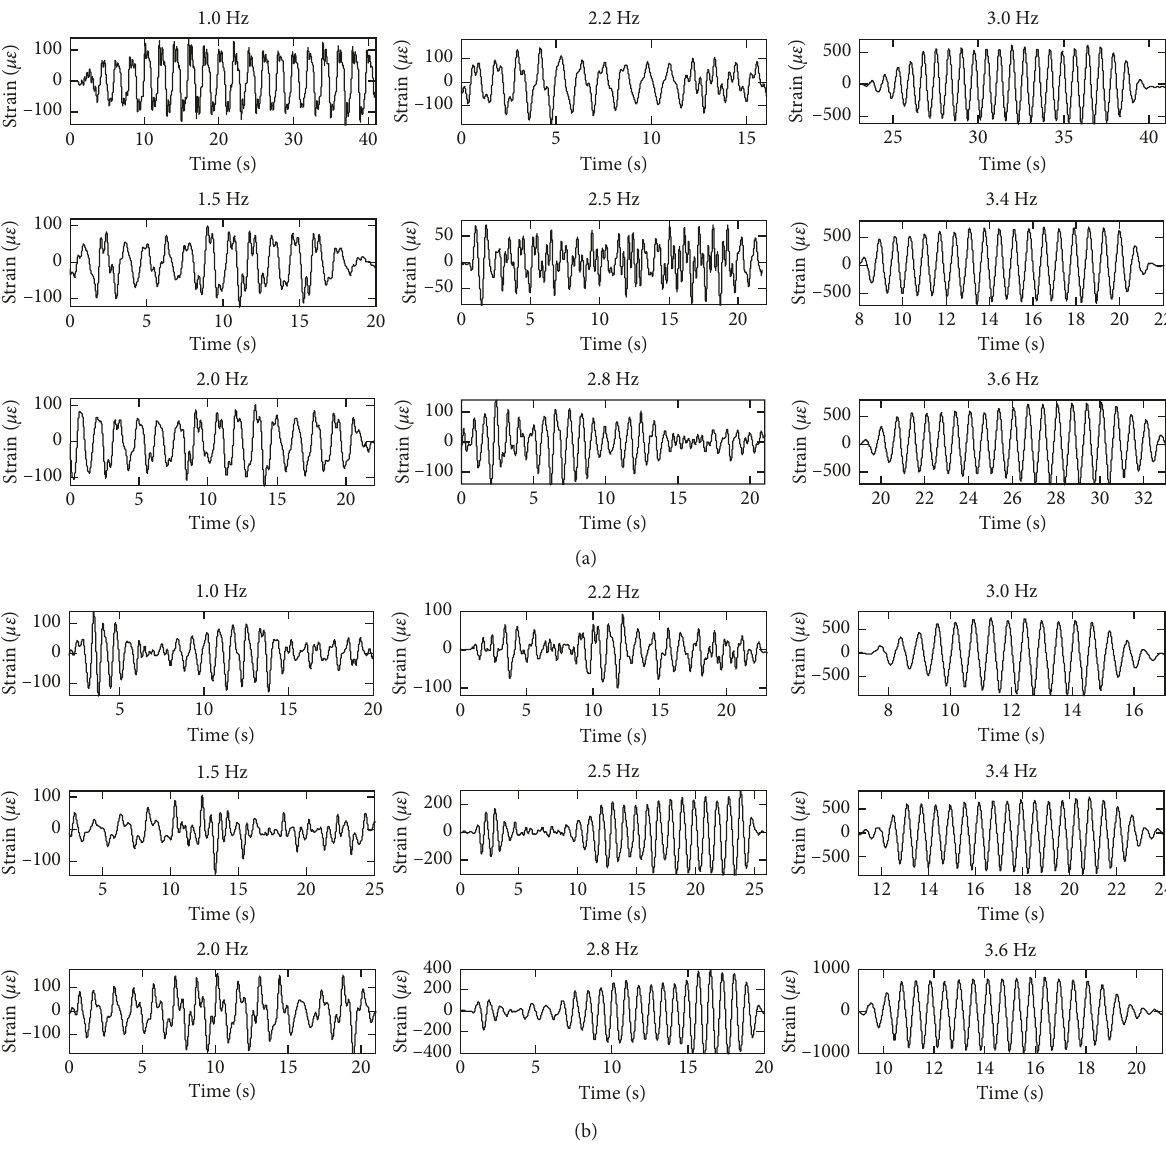
Figure 13: The structural strain of point S25 when all crowd swaying. (a) The results of standing crowd had swaying and (b) the results of seated crowd had